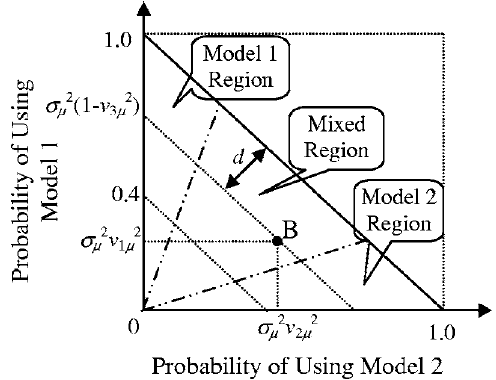
FIG. 4. Model regions on model plot. The model 1 (cid:1) model 2 (cid:2) region represents comparatively consistent model states with domi- nant model 1 (cid:1) model 2 (cid:2) components. The mixed model region rep- resents mixed